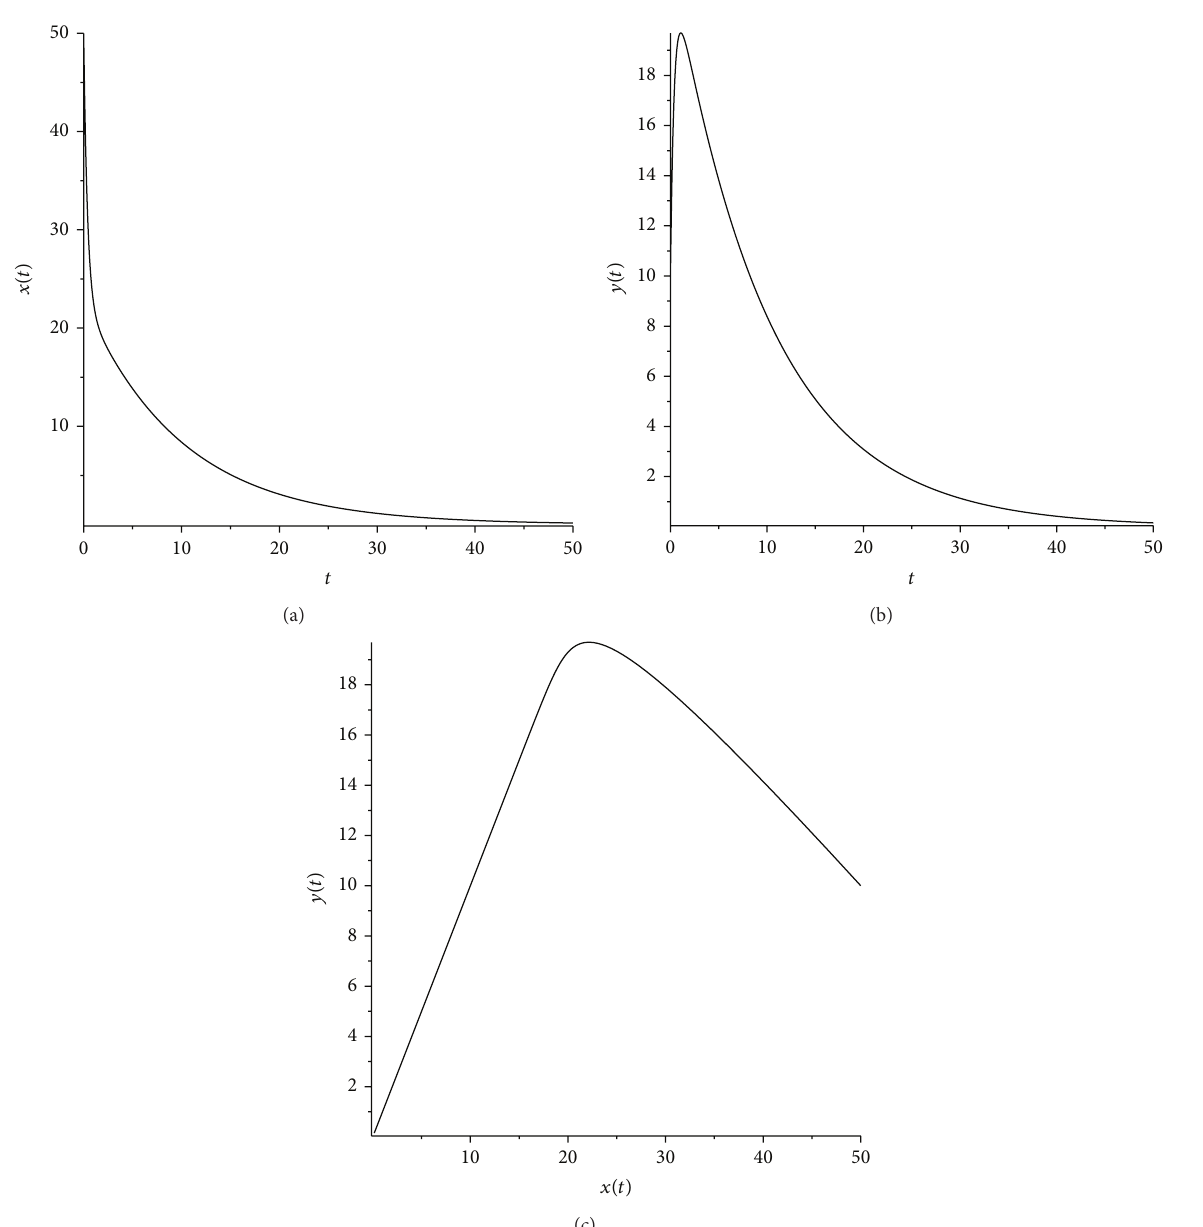
Figure 11: Time series and phase portrait of system (1) with 𝑎 = 1 . 7 , 𝑏 = 1 . 8 ,𝑐 = 0 . 8 ,𝑑 = 0 . 9 , 𝑥 ∗ = 50 , 𝛼 = 0 , 𝛽 = 0 , (𝑥 0 , 𝑦 0 ) = ( 50 , 10 ) .